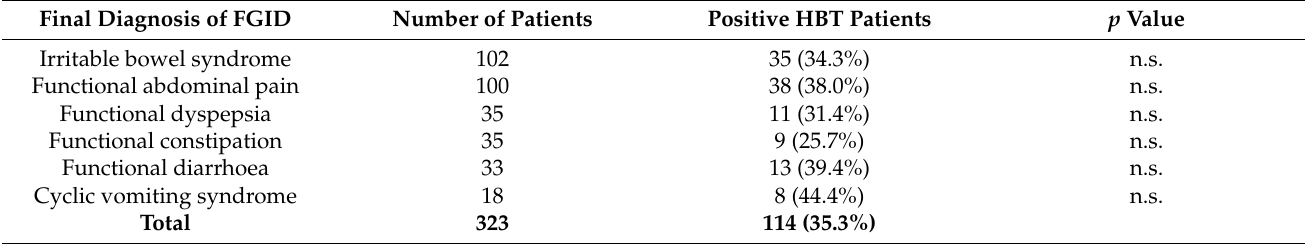
Table 3. The distribution of positive HBT results according to the final diagnosis of functional gastrointestinal